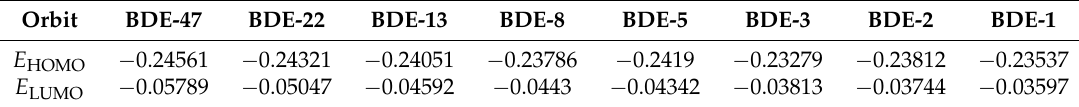
Table 8. The orbital energies (hartree) of HOMO and LUMO for the selected neutral BDE congeners.